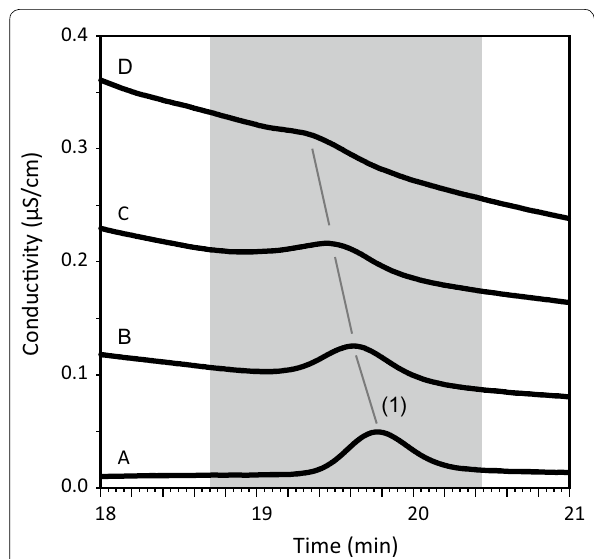
Fig. 1 Influence of matrix ions (MI) on a 10 µg/L perchlorate signal; A (0 mg/L MI); B (100 mg/L MI); C (200 mg/L MI); D (400 mg/L MI); (1) 10 µg/L perchlorate; signal offset of 10% was